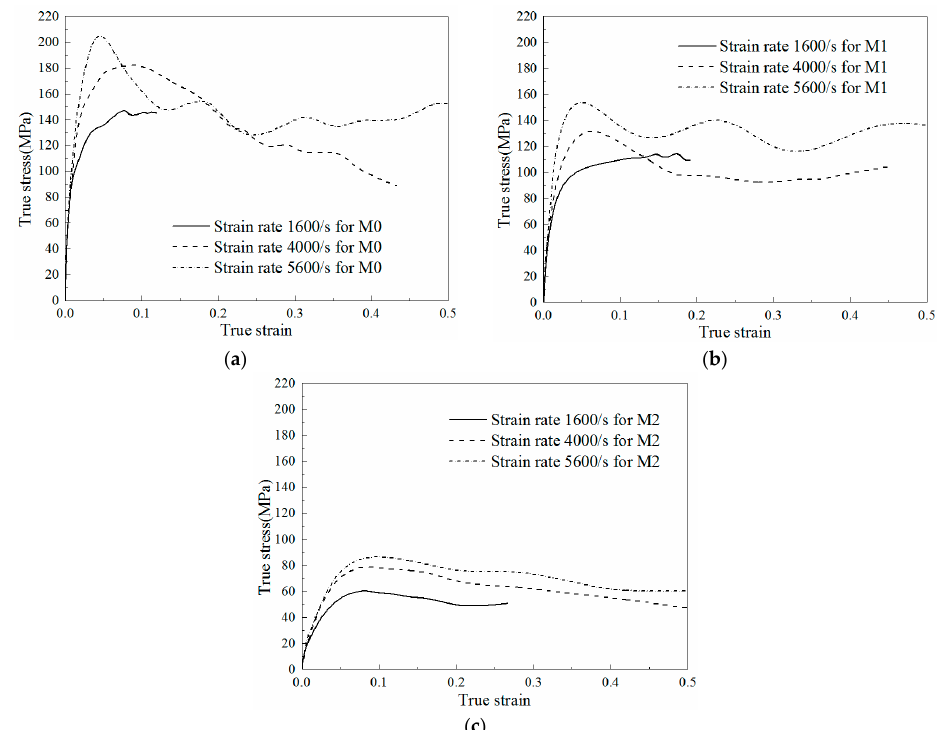
Figure 6. Dynamic stress-strain curves of three specimens with different LNBR content: ( a ) 0% (M0); ( b ) 10% (M1); ( c ) 25% (M2) at different strain rates.